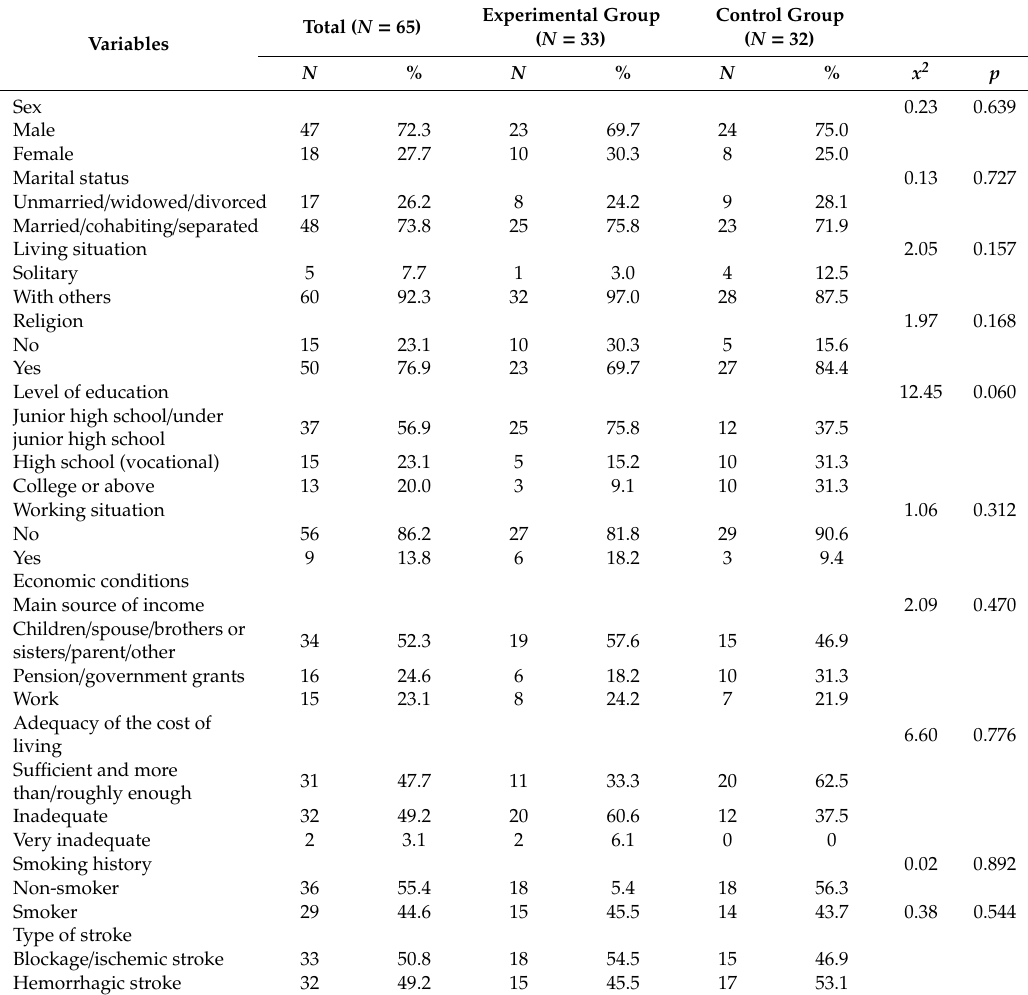
Table 1. Comparison of homogeneity between the two groups in terms of the basic characteristics before the